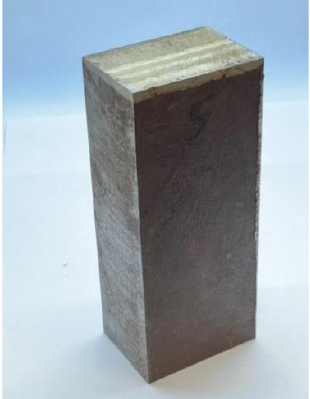
Figure 2. Photograph of the cladded block.